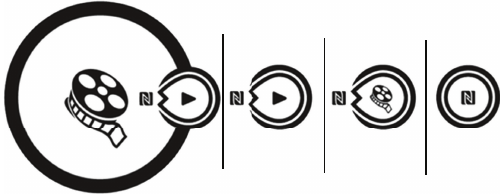
Figure 6: Service advertisements presenting di ff erent amounts of